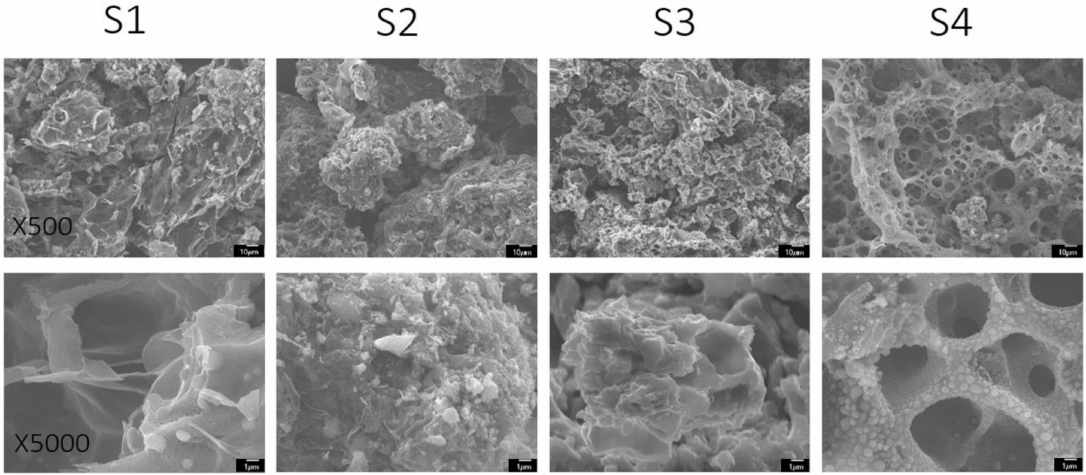
Figure 1. SEM images of co-doped soy-based carbon materials at 500 × magnification ( top row ) and 5000 × magnification ( bottom row